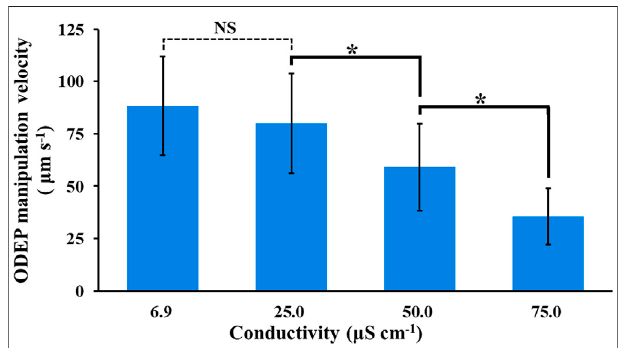
FIGURE4| EvaluationoftheODEPmanipulationvelocityofPC-3cancer cellsunderbackgroundsolutionswithvariedconductivity(6.9 – 75.0 μ S cm − 1 ). The results are presented as the mean ± standard deviation of at least three separate experiments. [NS, no signi fi cance and *, signi fi cant difference ( p < 0.05)].